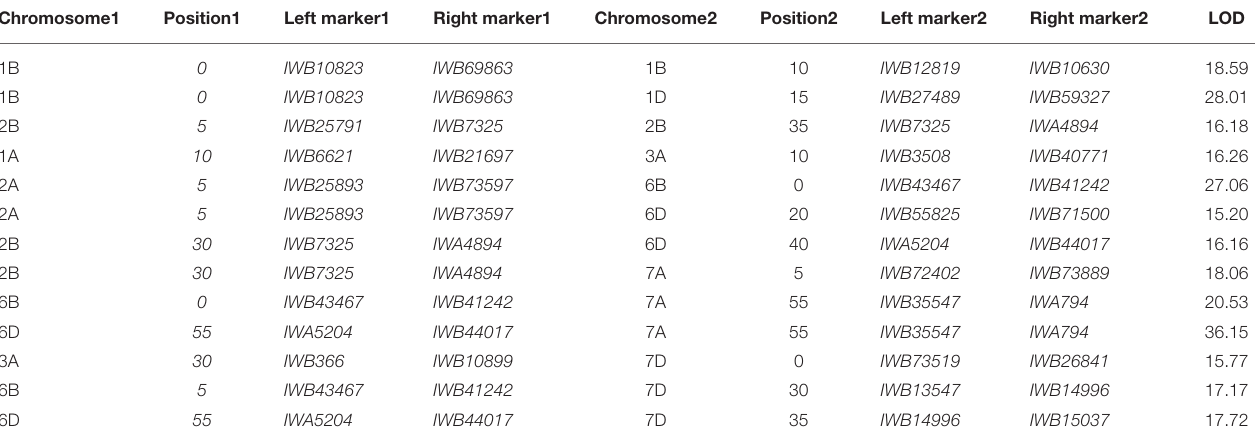
TABLE 6 | Multi-environmental analysis and digenic epistatic QTLs based on an ICIM-EPI analysis of the mean infection type (IT) and disease severity (DS) of the RILs from the cross of Mingxian 169 × Pindong 34 tested in Mianyang and Yangling in 2016–2020. Chromosome1